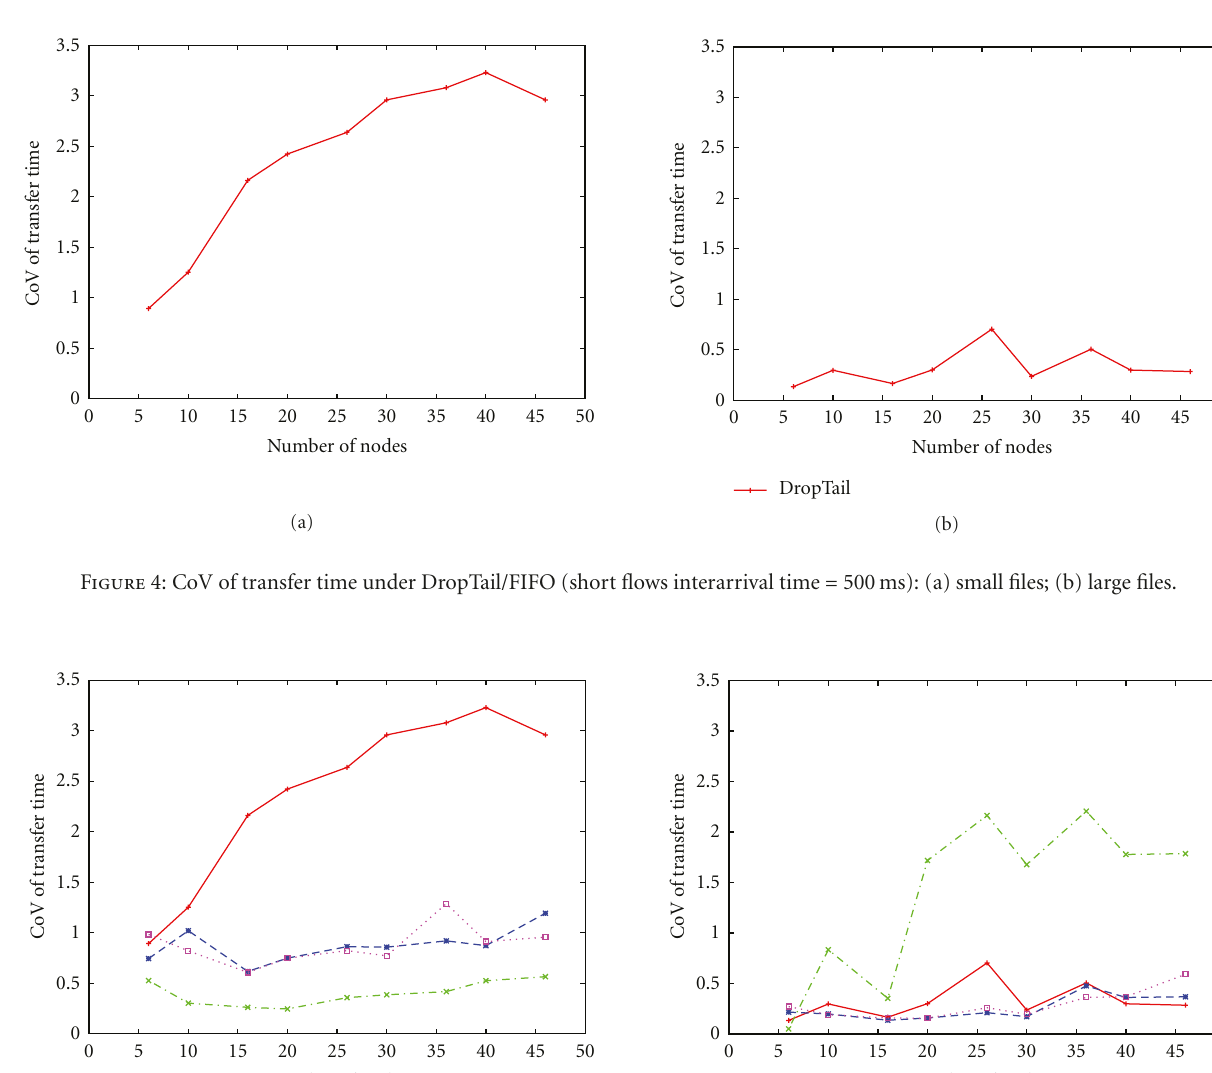
Figure 5: CoV of transfer time under TLAS-SAF and other studied policies (short flows interarrival time = 500ms): (a) small files; (b) large